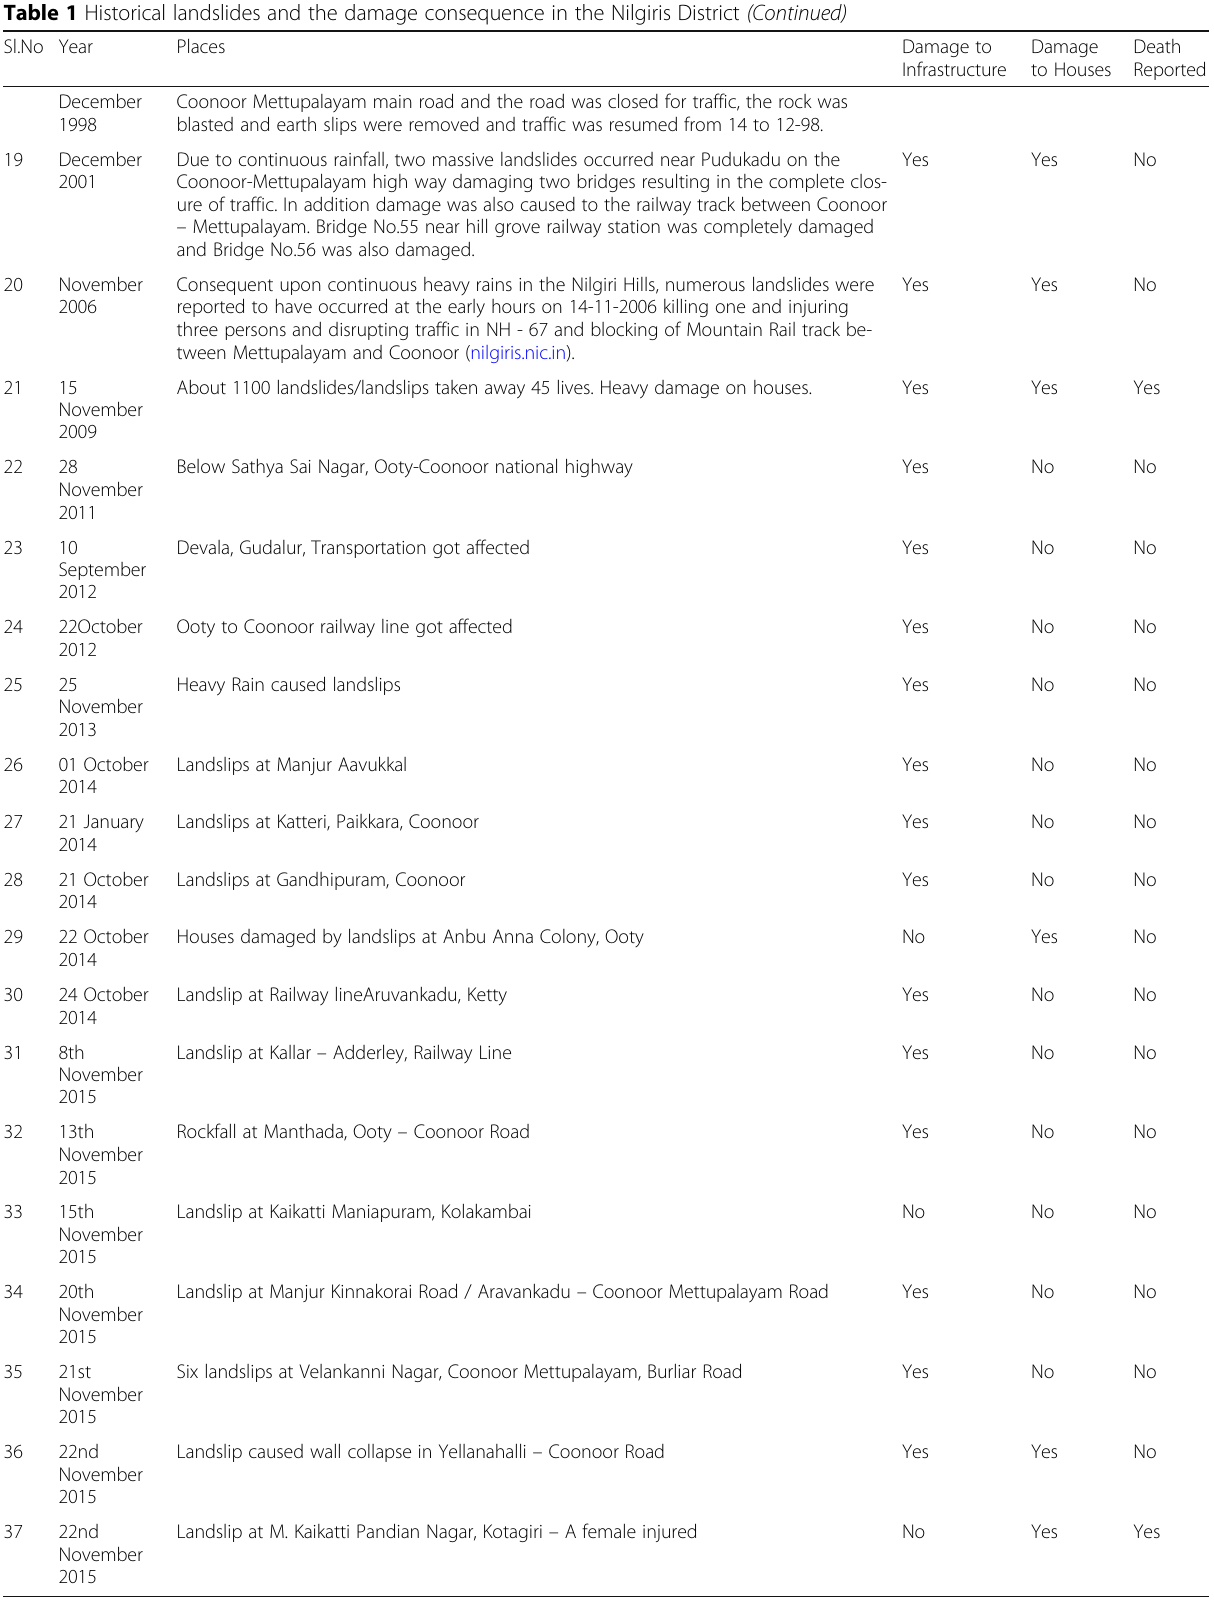
Table 1 Historical landslides and the damage consequence in the Nilgiris District